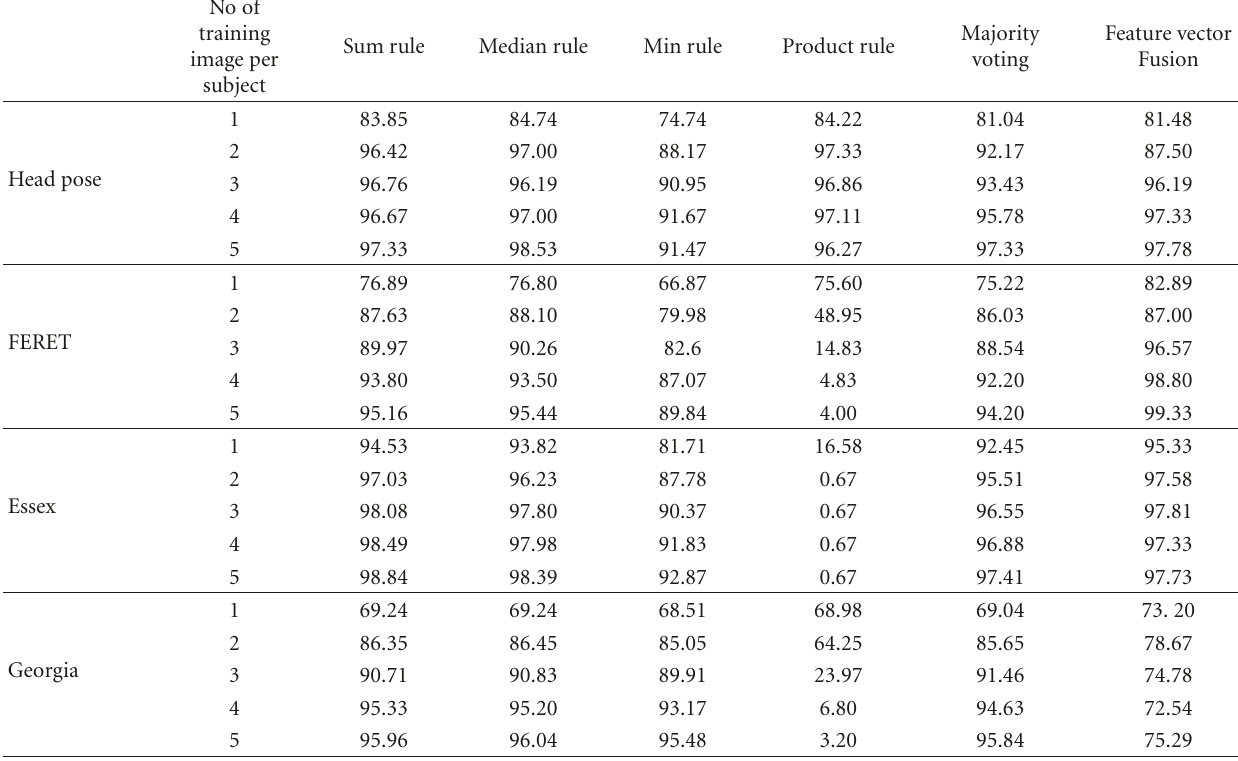
Table 4: Performance of di ff erent decision making techniques for the proposed face recognition